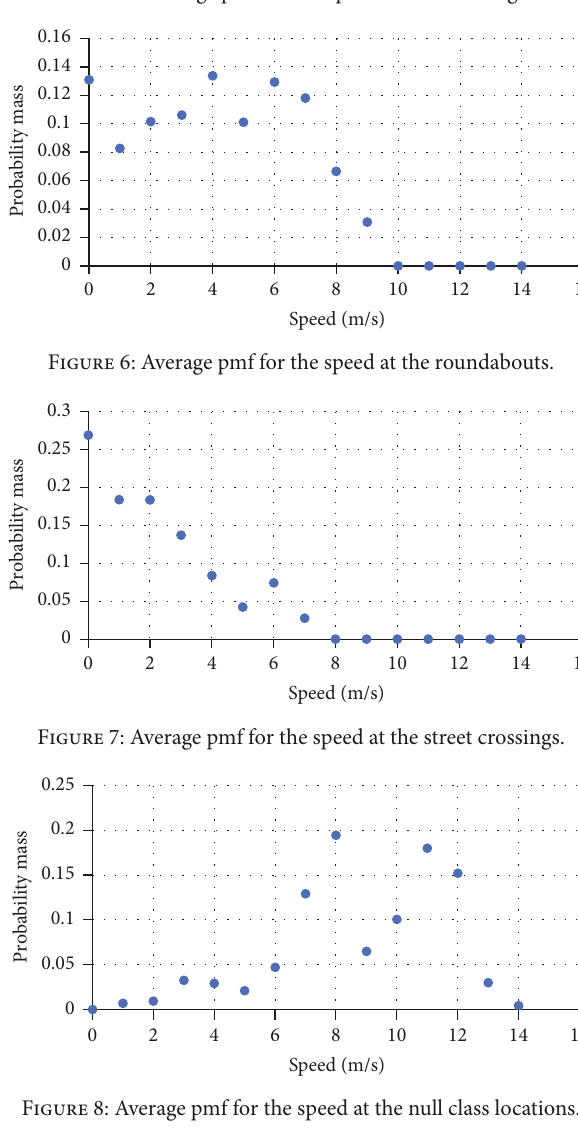
Figure 5: Average pmf for the speed at the traffic lights.